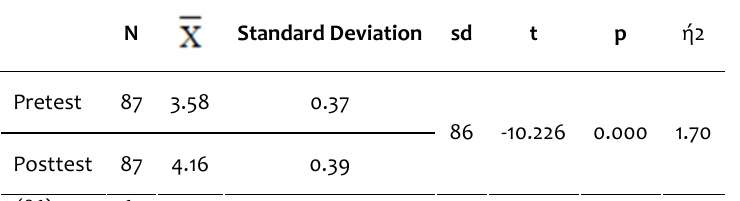
Table 4. Comparison of pre-post test ecological footprint awareness scores with dependent groups t-test N Standard Deviation sd t